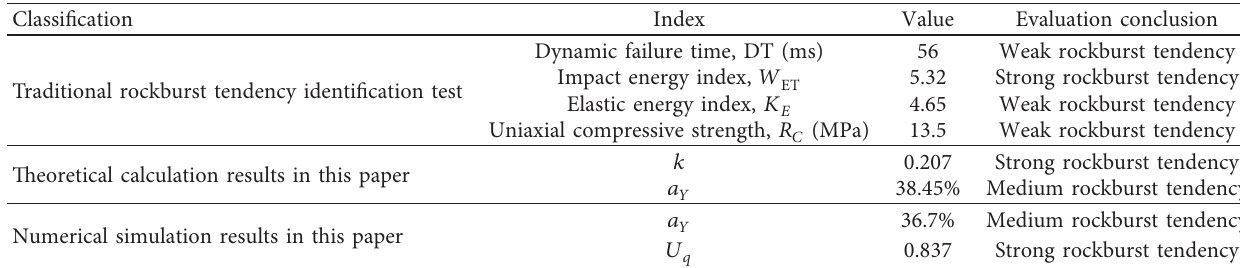
Table 3: Rockburst risk evaluation results of 3202